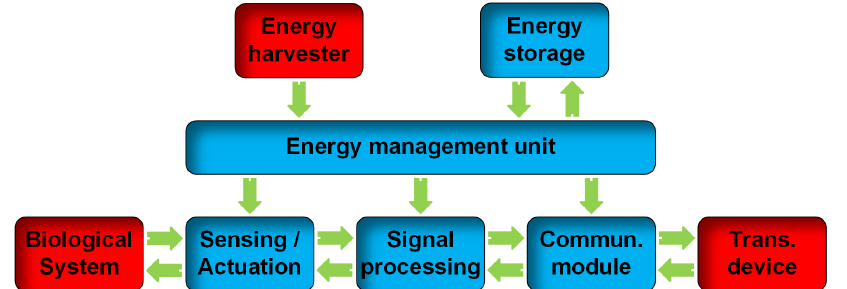
Figure 2. Block diagram of an implantable device with energy